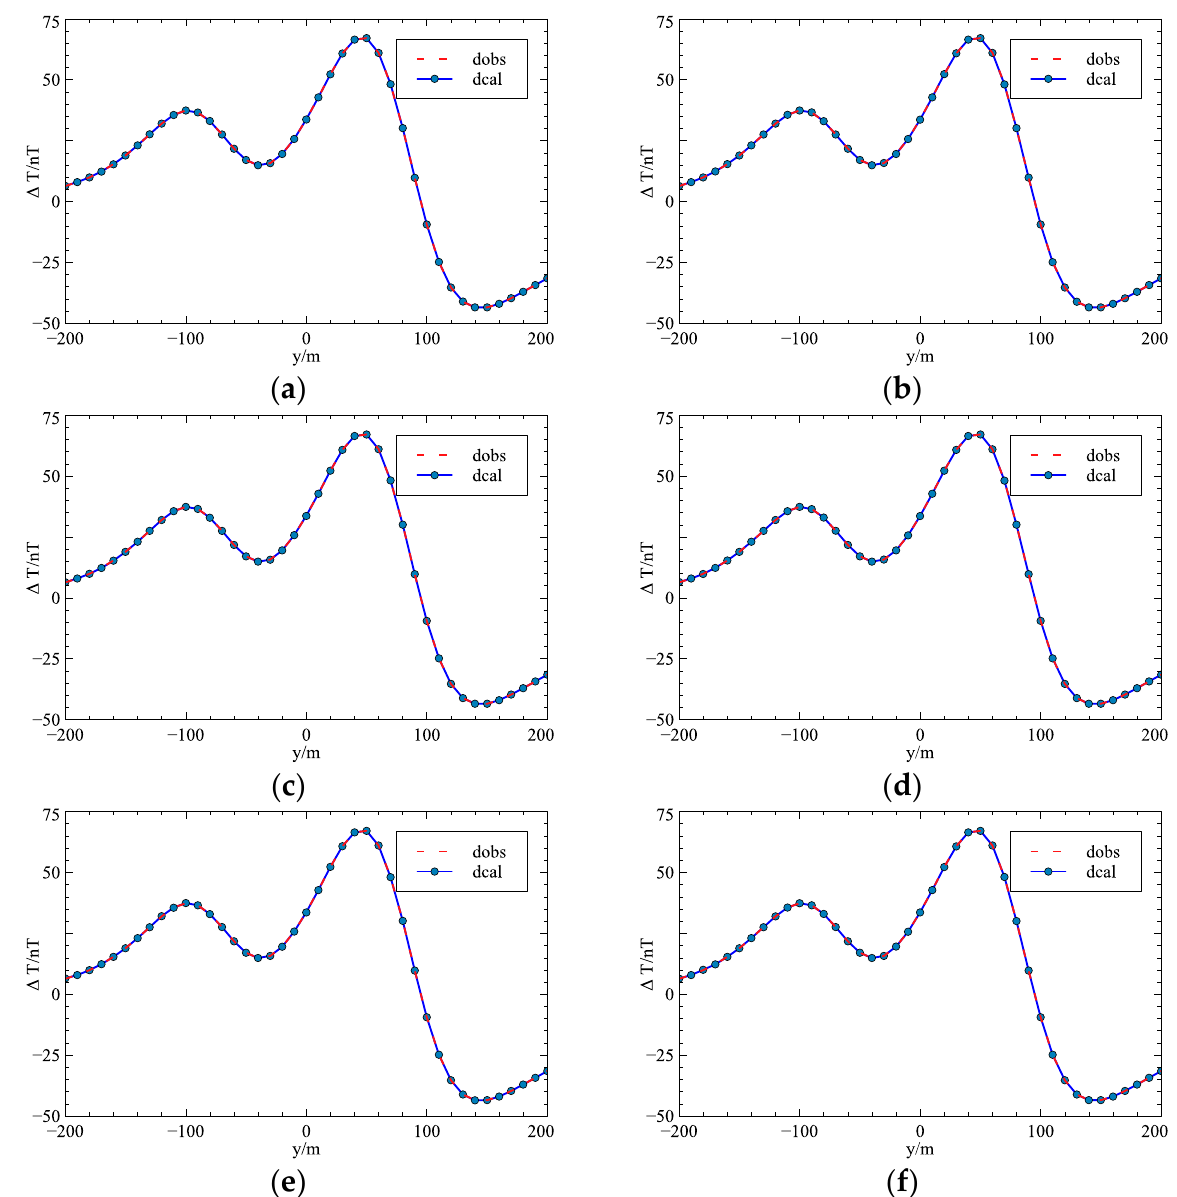
Figure 9. The inversion results of model 3 by using different p value. ( a ) (cid:1868) = 1.0 , ( b ) (cid:1868) = 1.1 , ( c ) p = 1.3, ( d ) p = 1.5, ( e ) (cid:1868) = 1.7 , ( f ) (cid:1868) = 2 .